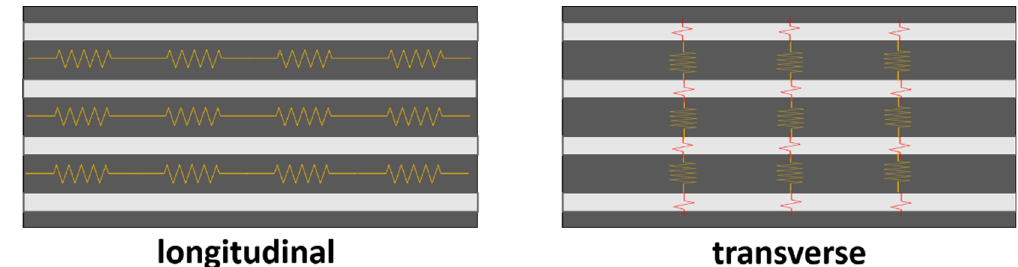
Figure 6. Schematics of the main electrical pathways in the longitudinal and transverse directions of the GFRP laminate.